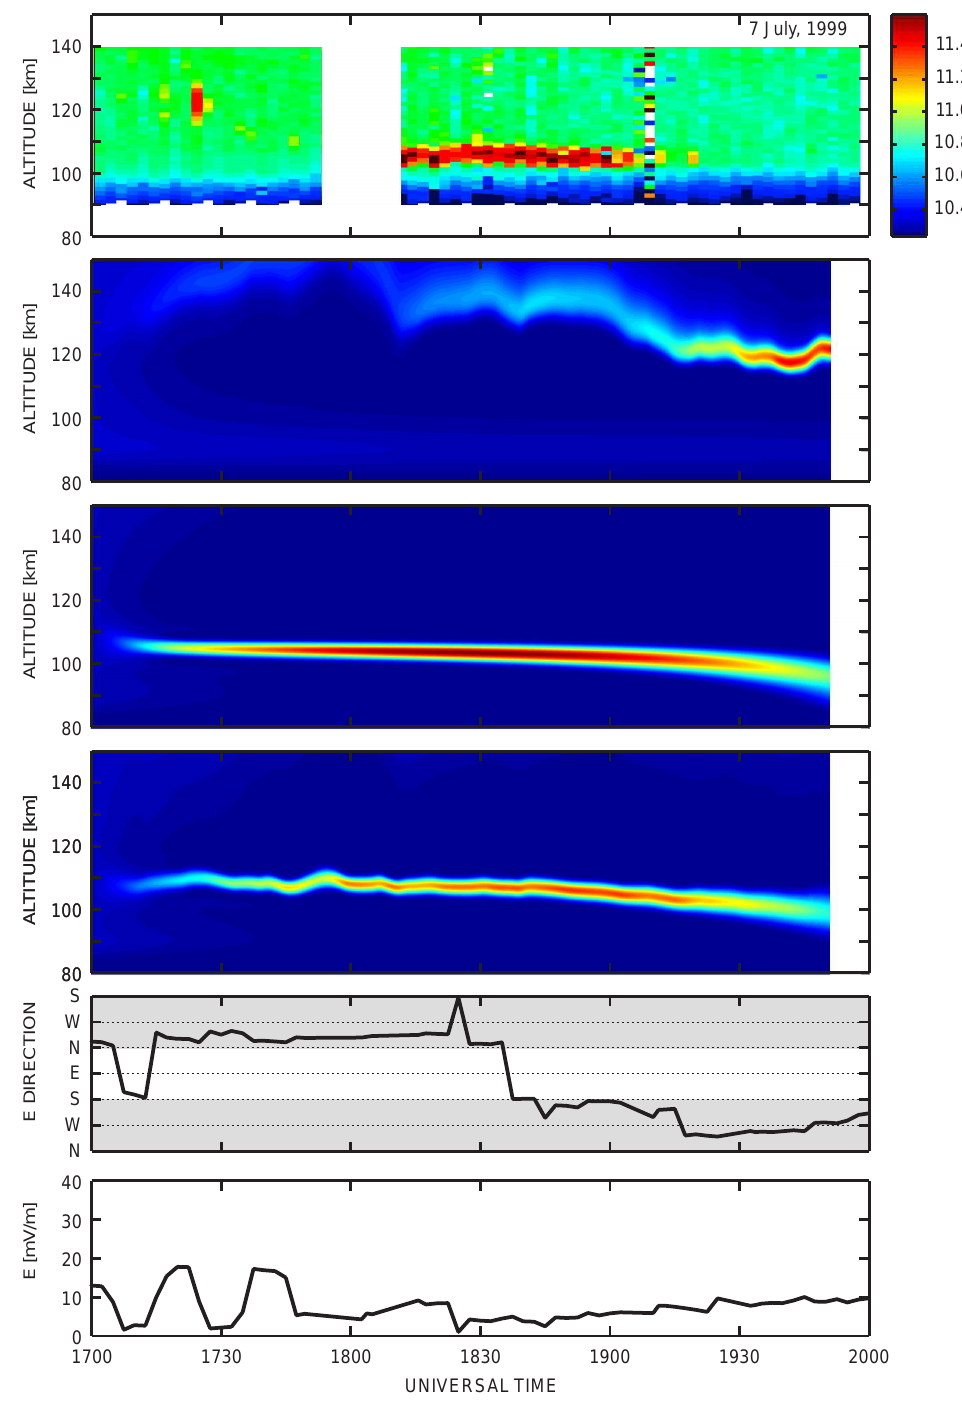
Fig. 3. Same as Fig. 1 for 7 July 1999.